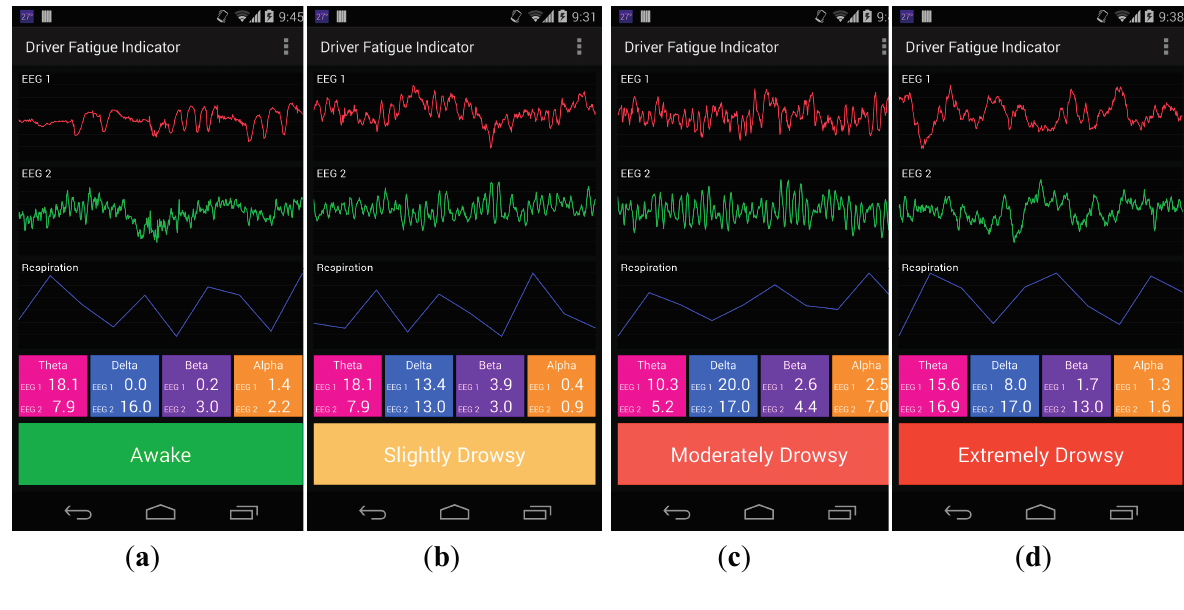
Figure 8. Sample screenshots of the four distinct driver sleepiness levels: ( a ) wakeful state (level 6); ( b ) slightly drowsy state (level 5); ( c ) moderately drowsy state (level 4); and ( d ) extremely drowsy (level